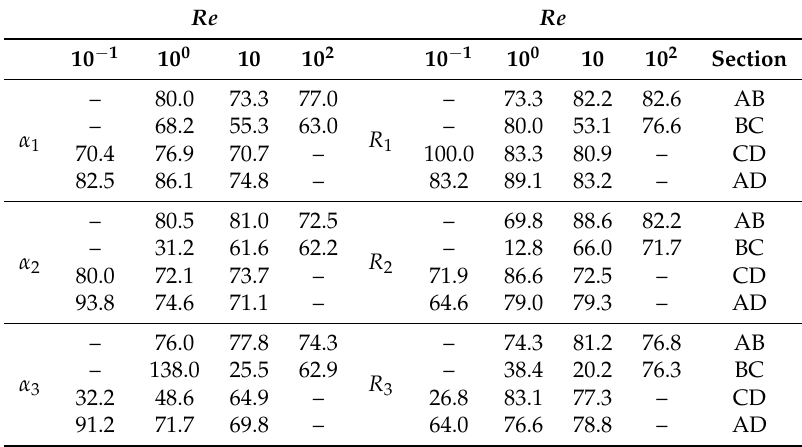
Table 3. Percentage error (%) between experimental and analytical data for pressure taps with sub-channel width w 1 = 54 µ m.